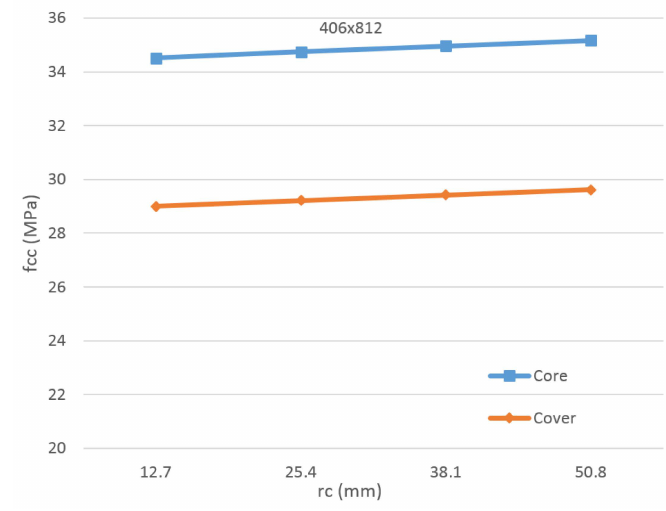
Figure 23. Core and cover confined strengths for the section of 406 ˆ 812 mm.